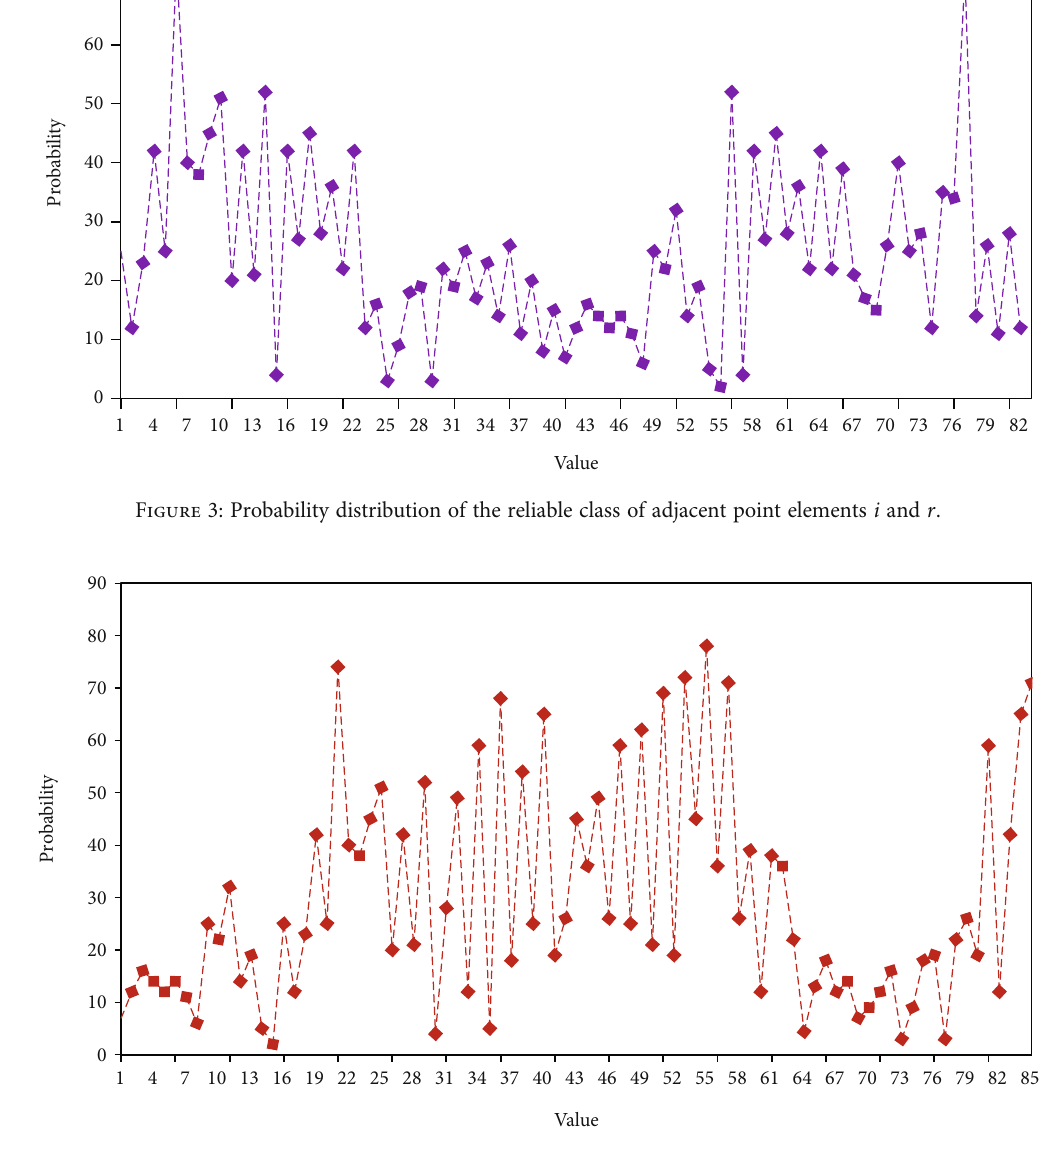
Figure 4: Probability distribution of adjacent points i and r are multiple matching